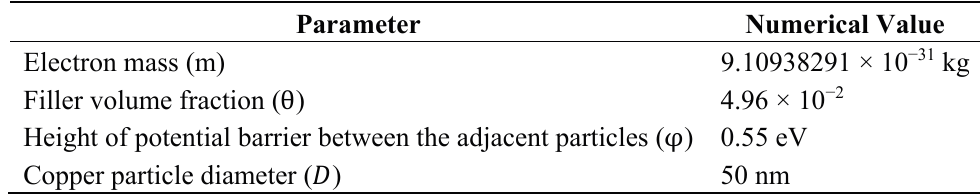
Table 2. Required parameters and